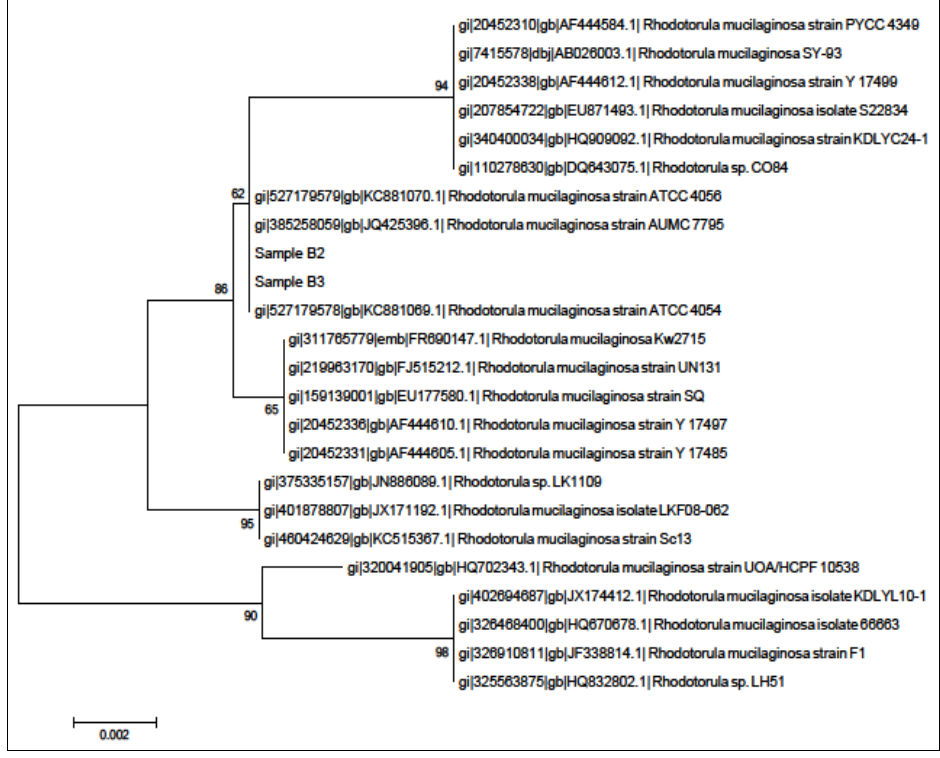
Figure 2. Phylogenetic analysis of isolates B2 and B3 analysed using MEGA 5.2 Molecular identification of isolates B2 and B3 based on 18S rDNA phylogenetic analyses suggested both isolates are closely related to Rh . mucilaginosa .